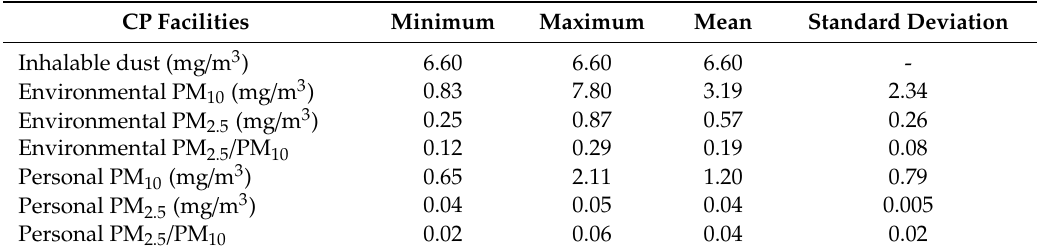
Table 7. Particulate matter and inhalable dust monitoring for the CP facilities. CP = composting plants. CP Facilities